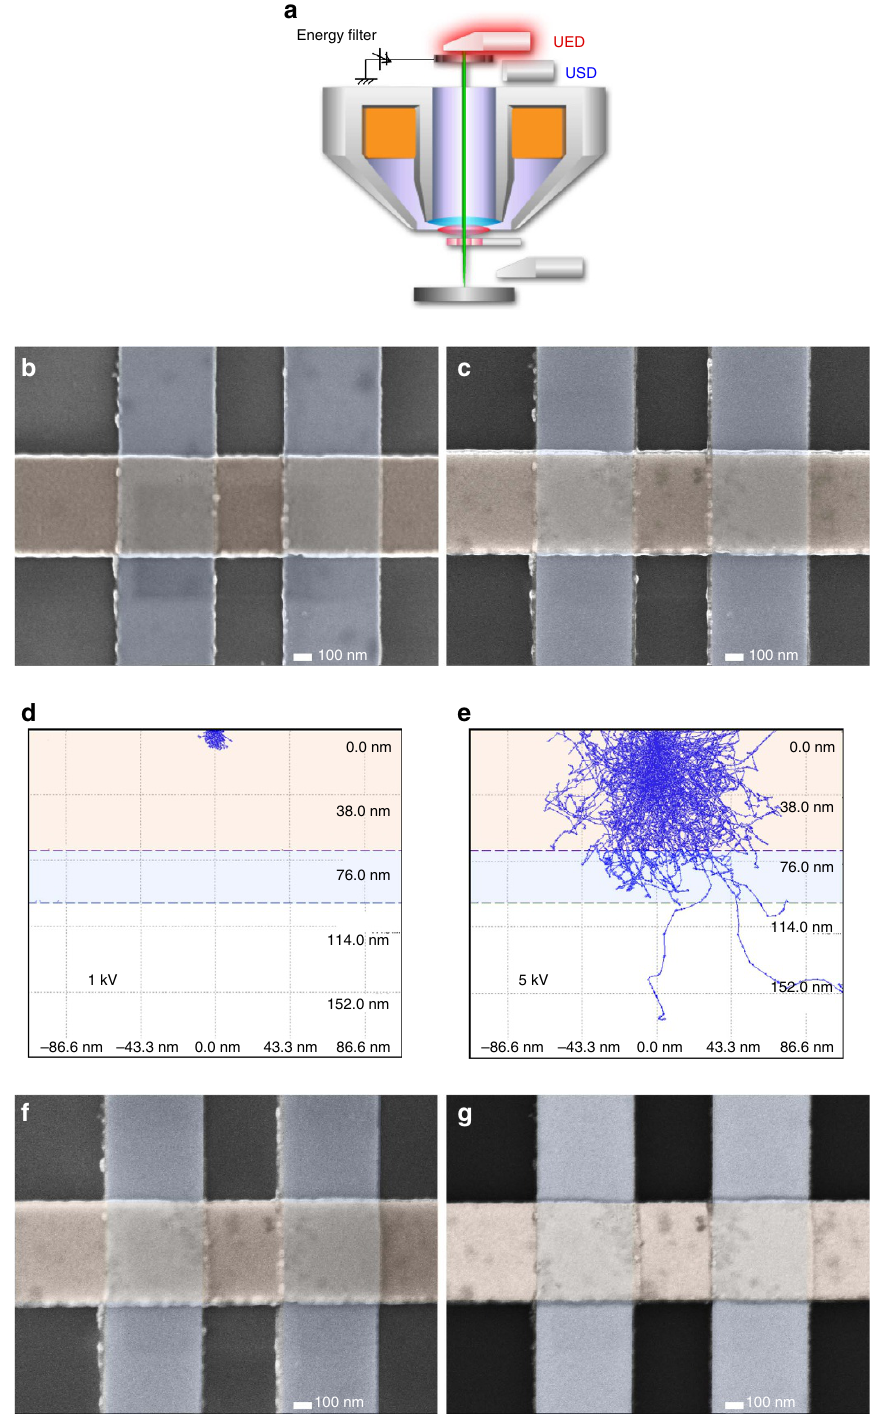
Figure 2 | Imaging of the fresh lateral spin–valve with decelerated electron beam. ( a ) Proposed technique in this study for the junction evaluation by decelerating electron beam to control its penetration depth to meet the vertical position of the junction. The alignment of the upper electron detector (UED), the upper secondary electron detector (USD) and the energy filter used in this study is also shown. ( b ) Scanning electron microscopy (SEM) image taken by UED with the secondary electron (SE) mode at V acc ¼ 1keV, which can penetrate into 10nm below the surface. False blue and orange colour is provided for Ni 0.8 Fe 0.2 and Cu wires. ( c ) Corresponding SEM image taken at V acc ¼ 5keV, which can penetrate into 100nm below the surface. ( d , e ) Interaction volume simulations to estimate the penetration depth for b , c . ( f ) SEM image taken by USD with the SE mode at V acc ¼ 5keV using energy filter below (cid:2) 500Vas. ( g ) Corresponding SEM image taken by UED with the backscattered electron (BSE) mode at V acc ¼ 5keVusing energy filter above (cid:2)